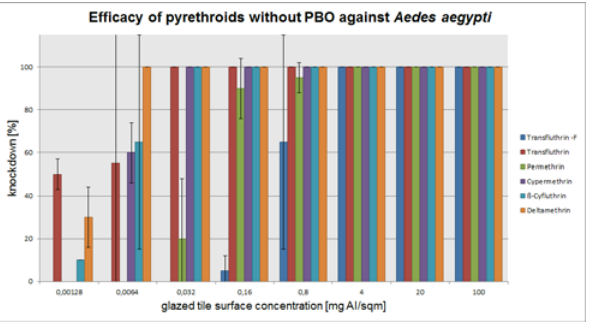
Fig 3. Arithmetic means and standard deviations of the 1 h results of a glazed tile contact bioassay using technical grade pyrethroids without PBO against insecticide susceptible Aedes aegypti